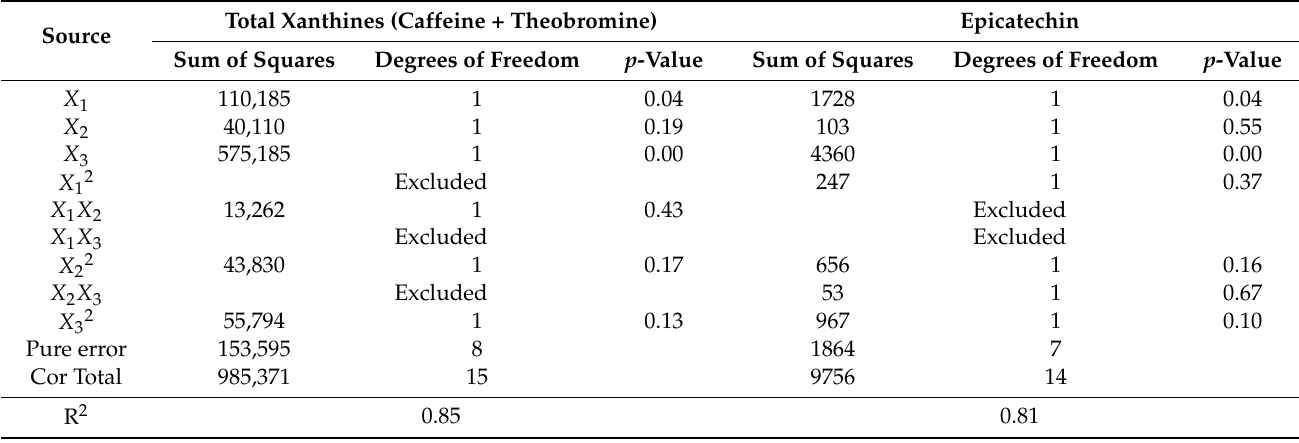
Table 2. ANOVA results on the extraction of methylxanthines and epicatechin from cocoa bean shells (BS). Source